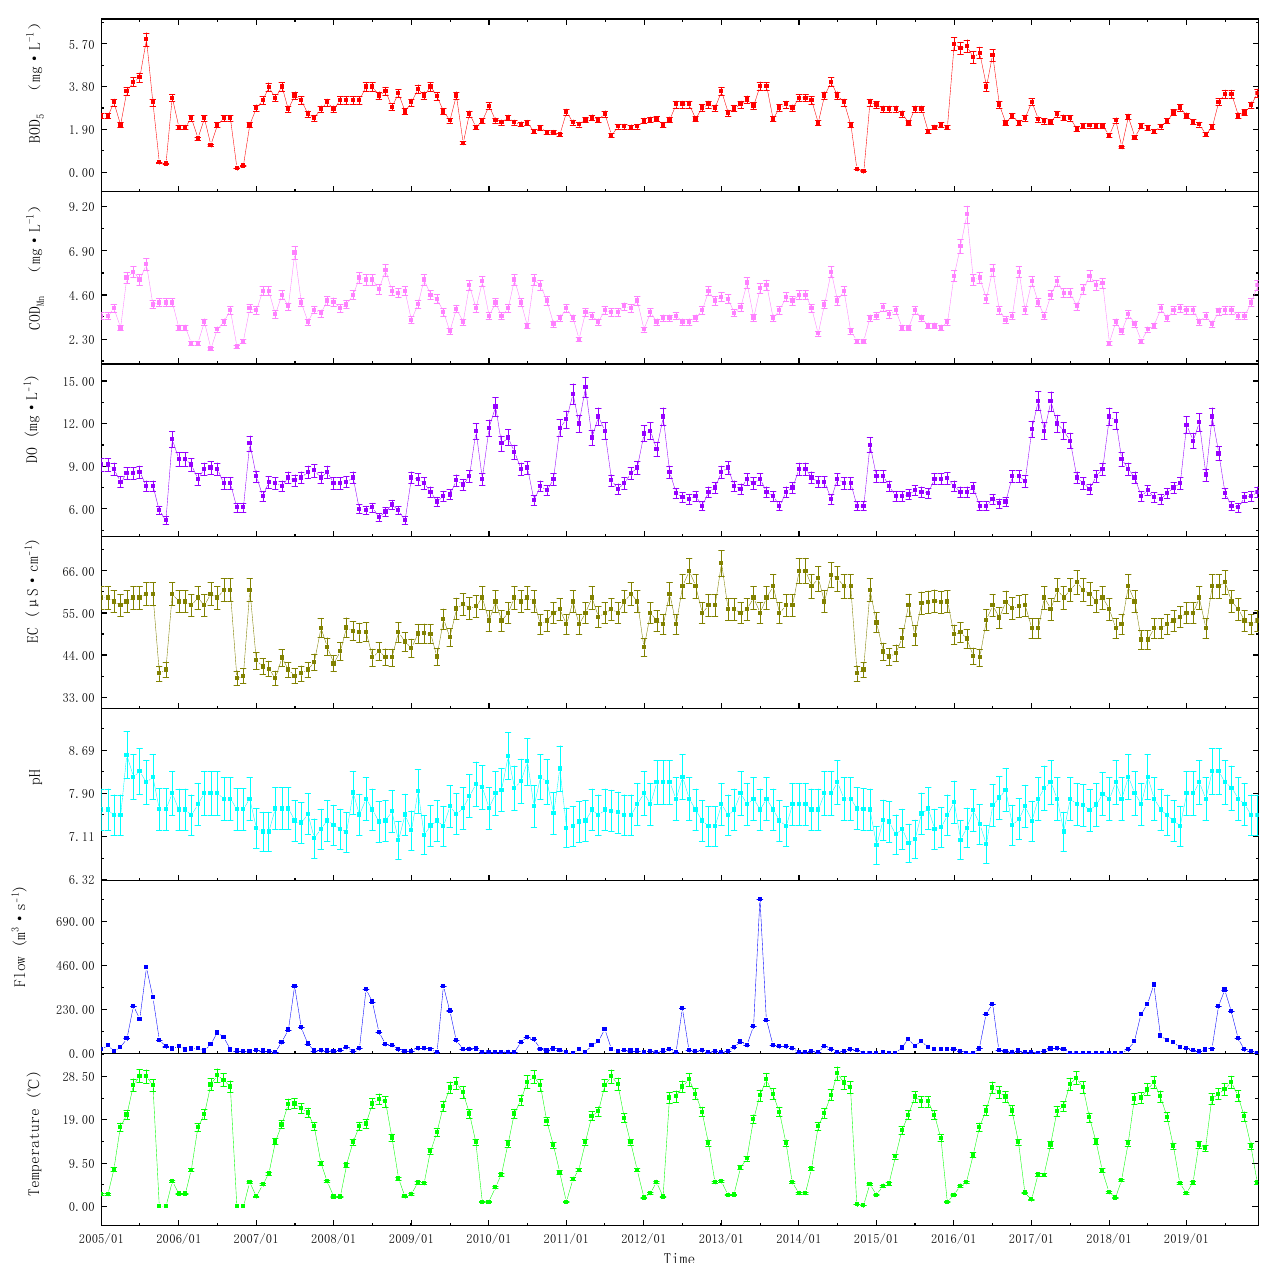
Figure 4. Changes in environmental factors in the River Yi from 2005 to 2019 (means ± SD).